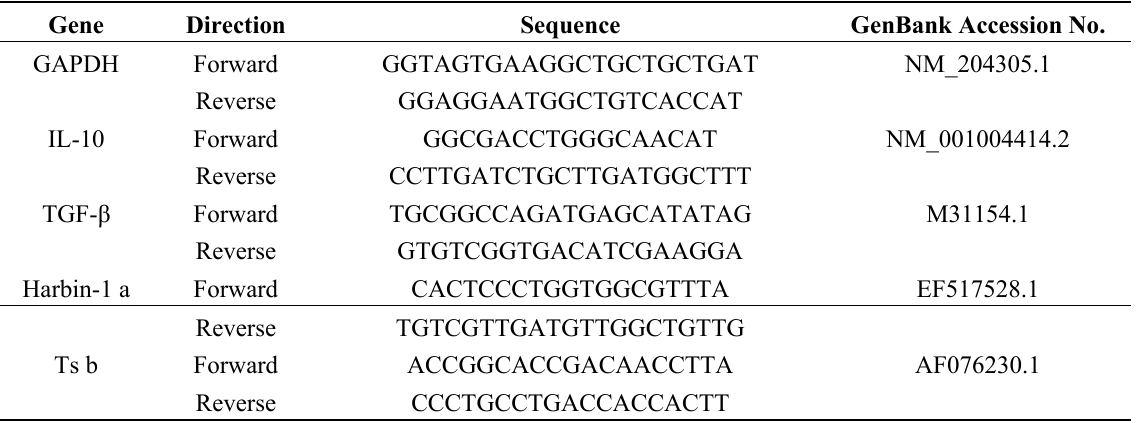
Table 1. Sequences of the primers used in